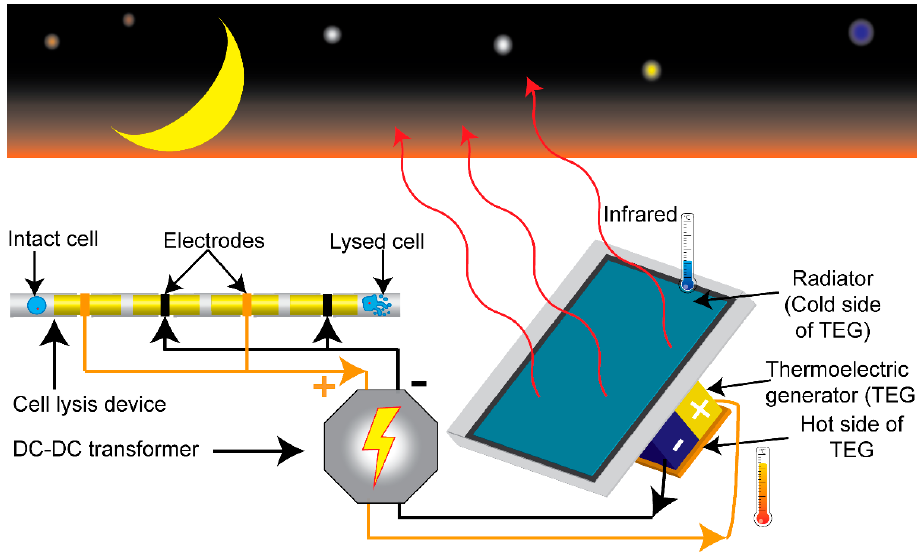
Figure 1. Overall schematic of the off-grid electrical cell lysis system.